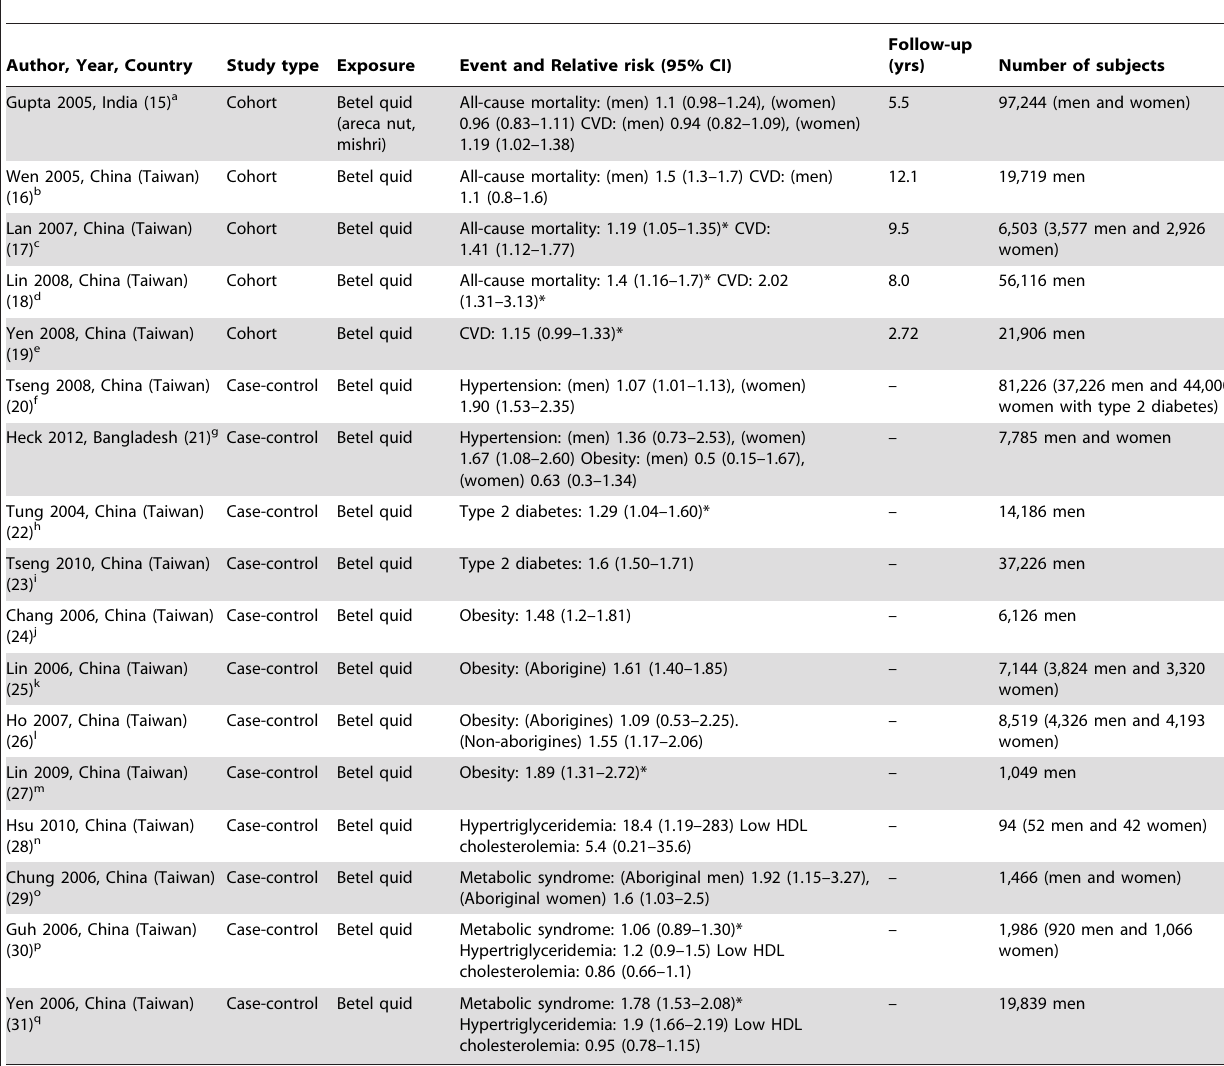
Table 1. Summary of studies evaluating the association of chewing betel quid with metabolic disease, cardiovascular disease, and all-cause